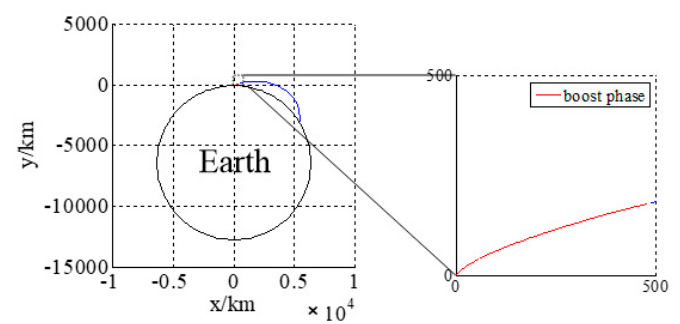
Figure 6. Trajectory in launch coordinate system.